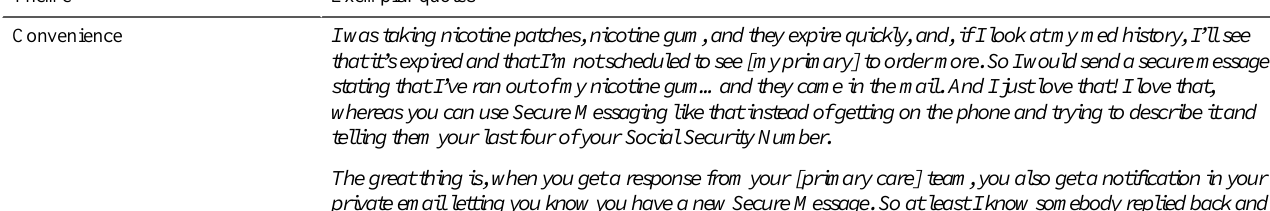
Table 5. Exemplar quotes of facilitators of using Secure Messaging. Exemplar